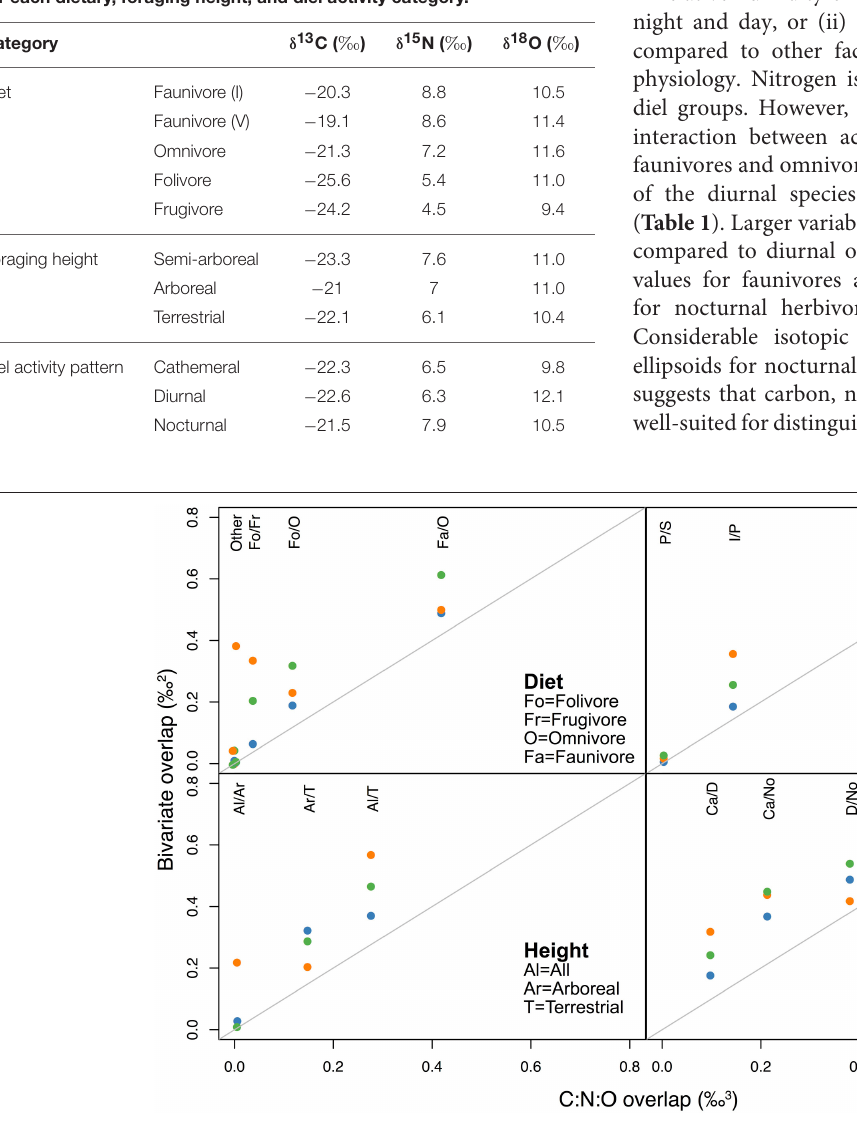
FIGURE 4 | Mean overlap values for 2-dimensional vs. 3-dimensional isotope systems for diet, trophic, canopy position (height), and activity categories. The “other” comparisons in panel a include Fa/Fo, Fa/Fr, and Fr/Om. Overlap values for all of these pairwise comparisons are very close to zero (see Supplementary Table